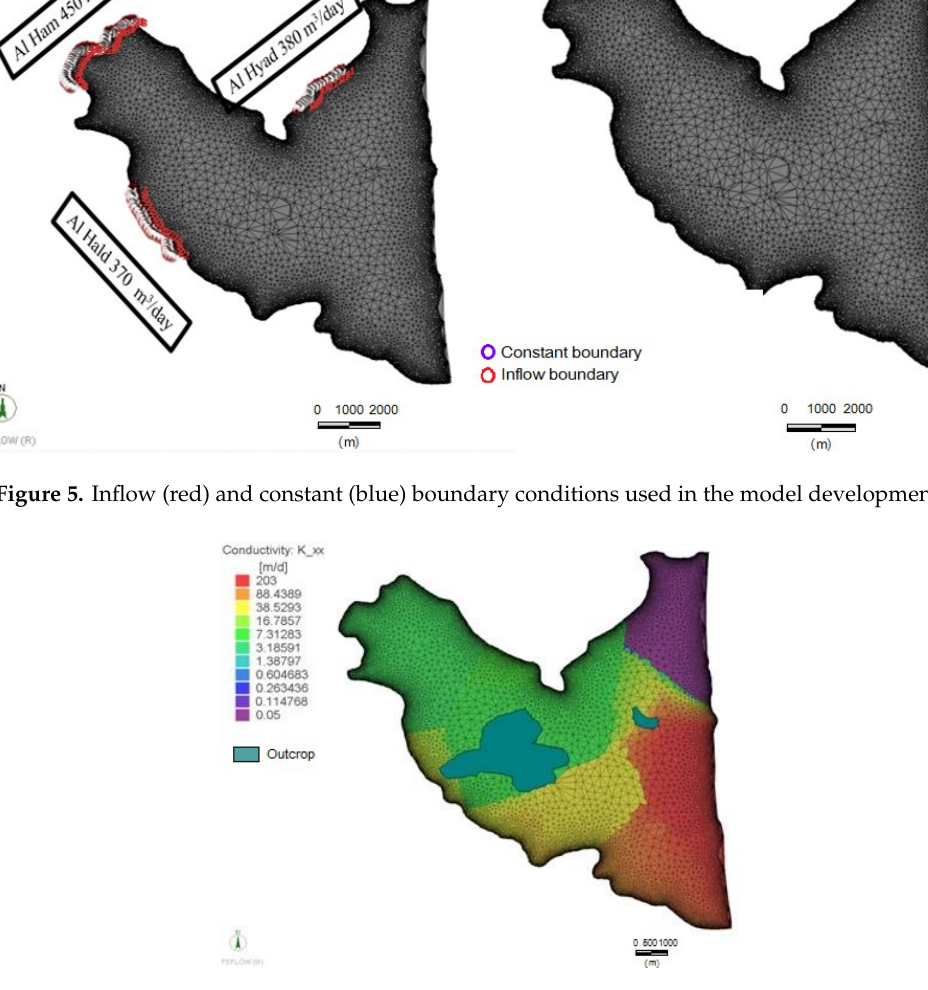
Figure 6. Hydraulic conductivity distribution obtained by pumping test [28].